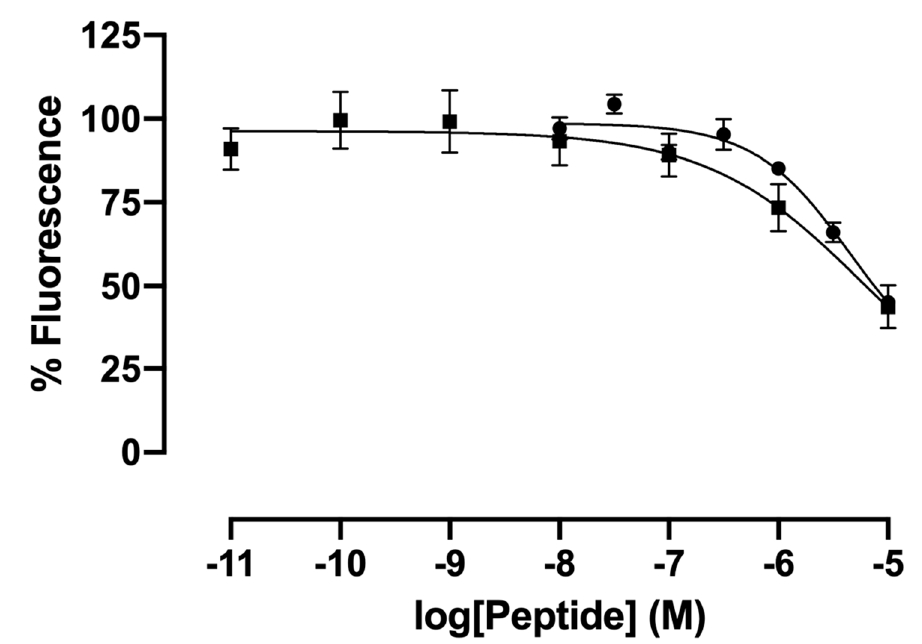
Figure 4. Effect of graded concentrations of Phe-modified 26RFa (20 − 26) analogs on 26RFa-evoked [Ca 2+ ] i mobilization in G α 16 - h QRFPR-transfected CHO cells. Prototype dose-inhibition curves of [ pt BuPhe 22 ]26RFa (20–26) (LV-2068, 11 , closed circles) and [DTrp 26 ]26RFa (20–26) (LV-2188, 39 , closed squares) on 10 − 7 M 26RFa-evoked response. Data are mean ± SEM of triplicate. The IC 50 value calculated from these representative dose–inhibition curves were 4495 nM for 11 (LV-2068) and 5841 nM for 39 (LV-2188).